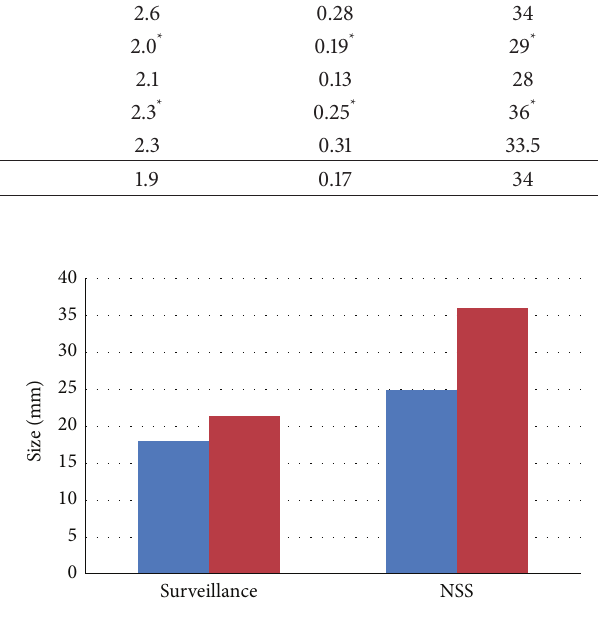
Figure 2: Masses size in both groups as observed at diagnosis and on last follow-up. Blue demonstrates size at diagnosis and red demonstrates size at last available follow-up. Masses diameter at diagnosis was significantly ( 𝑃 = 0.04 ) smaller in the group of patients whowere managed conservatively (18mmversus24.9